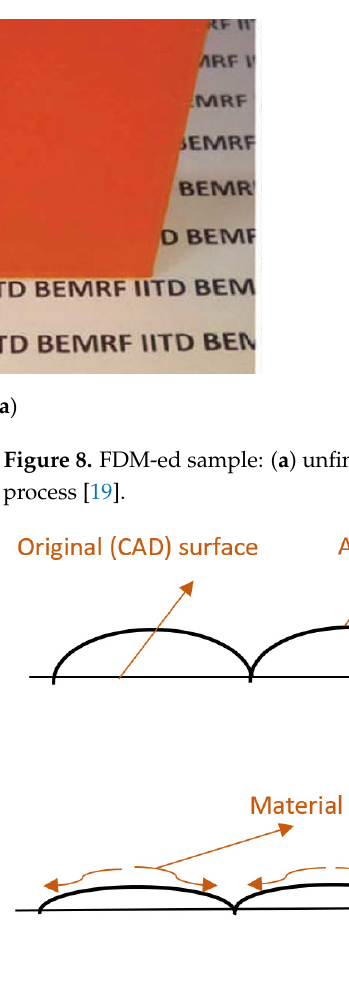
Figure 10. Surface finish improvement after chemical treatment [21].